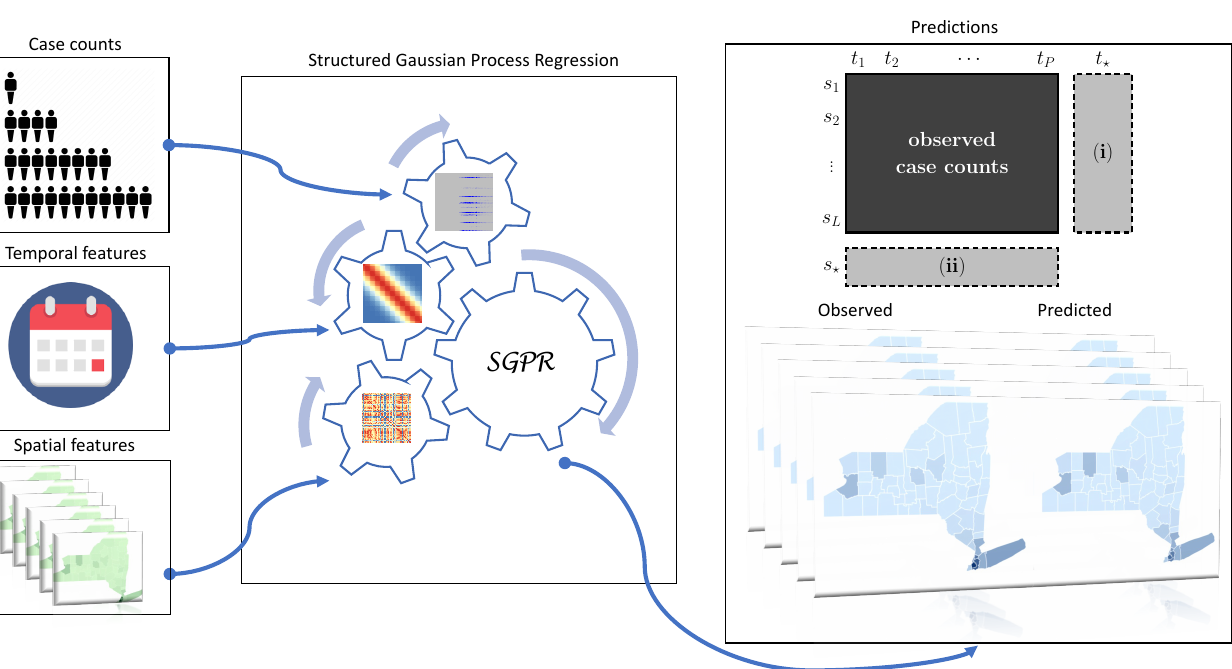
Figure A1. Overview of our predictive computational framework structured Gaussian process regression ( SGPR ).